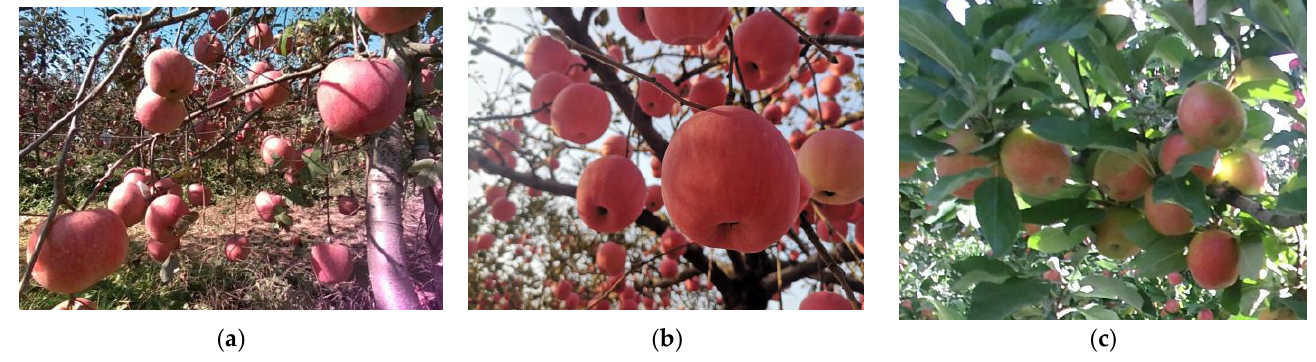
Figure 1. Example of the raw images in the MTOA dataset: ( a ) SD_ZY_IMG; ( b ) SD_QX_IMG; ( c ) WT_PSR_IMG. Table 1. Information about raw images of apple orchards.